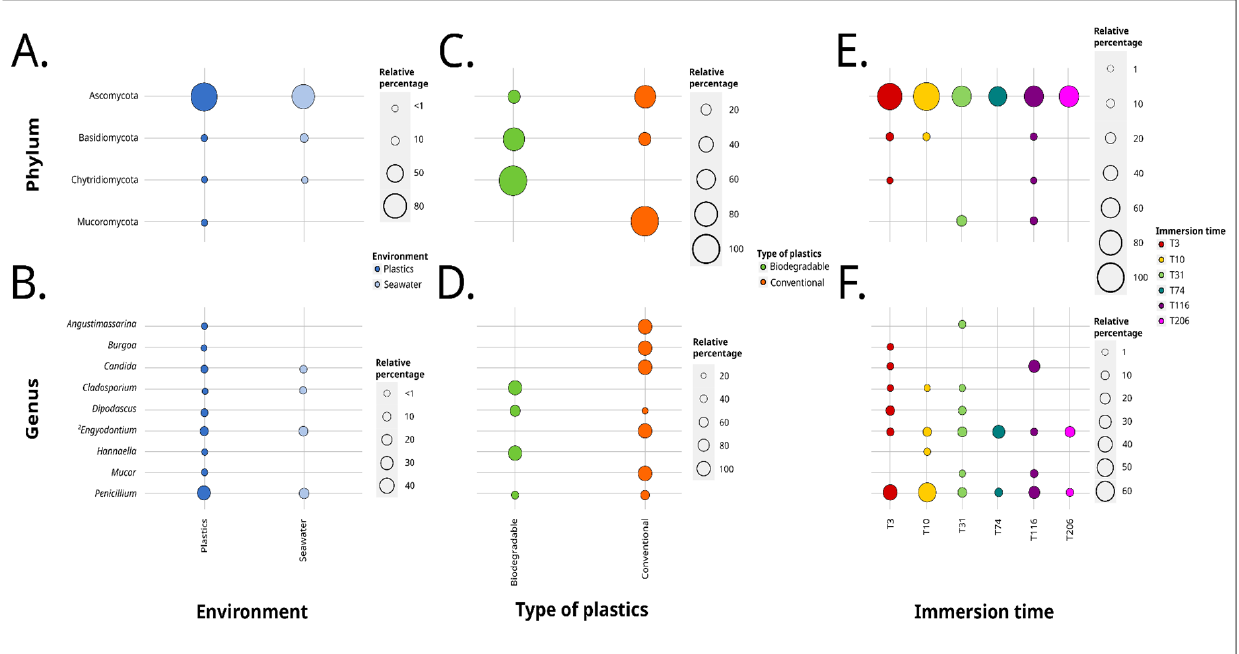
Figure 9. Bubble-plot representing the proportions of phyla or genus according to the variables ( A , B ) “Environment”, ( C , D ) ”Type of plastics”, and ( E , F ) “Incubation time” (days).